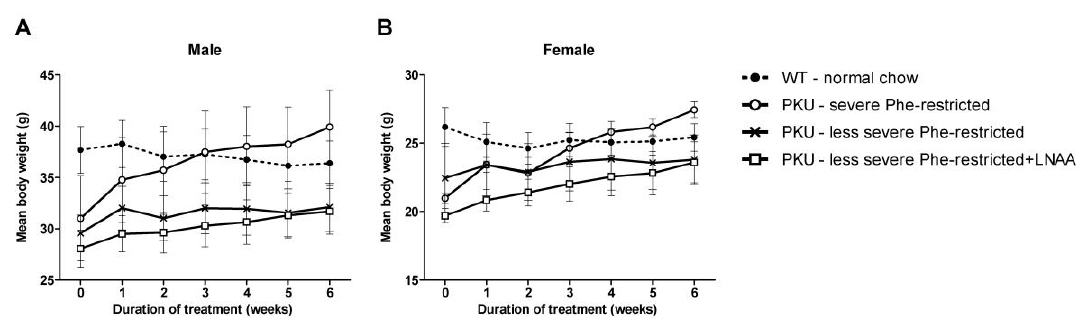
Figure 2. Mean body weights in male ( A ) and female ( B ) wild-type (WT) and phenylketonuria (PKU) mice on various diets during the six weeks of dietary treatment. Numbers of mice are n = 5 for all experimental groups. Untransformed data are expressed as mean ± standard error of the mean (SEM).